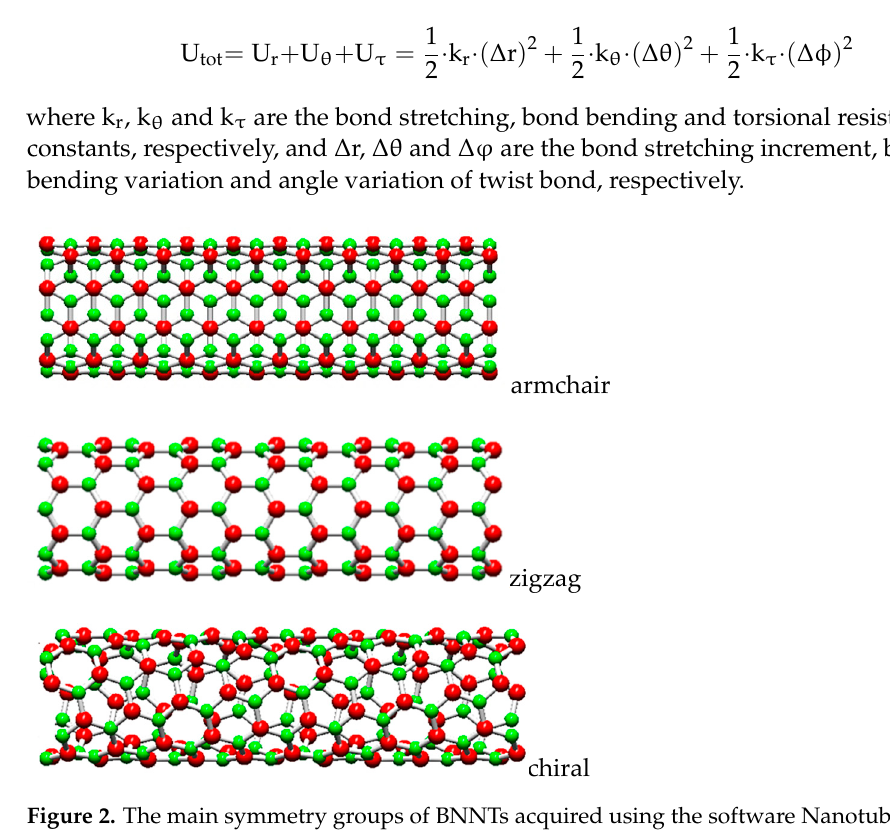
Figure 2. The main symmetry groups of BNNTs acquired using the software Nanotube Modeler© (version 1.8.0, ©JCrystalSoft).